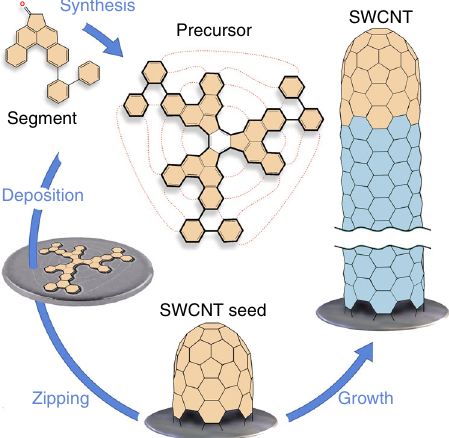
Fig. 1 Schematic representation of the fi rst rational surface-assisted synthesis of (6,6) SWCNTs 36 . The main steps are illustrated: precursor synthesis, precursor deposition on the metal surface, catalytic cyclodehydrogenation (zipping) to the SWCNT seed and the subsequent epitaxial elongation of the target chirality pure